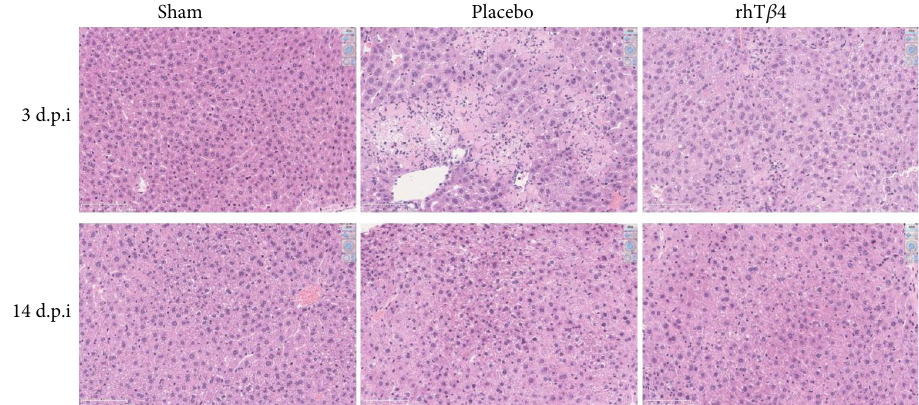
Figure 6: Pathological section of mice livers. Liver tissues were removed from the mice at 3 d.p.i. or 14 d.p.i., fi xed with 4% paraformaldehyde for examination. The samples were dehydrated, embedded, and sliced for HE staining, and the pathologies of the livers were evaluated under microscope (Nikon Ci-S, Japan). The magni fi cation of the pictures shown is ×